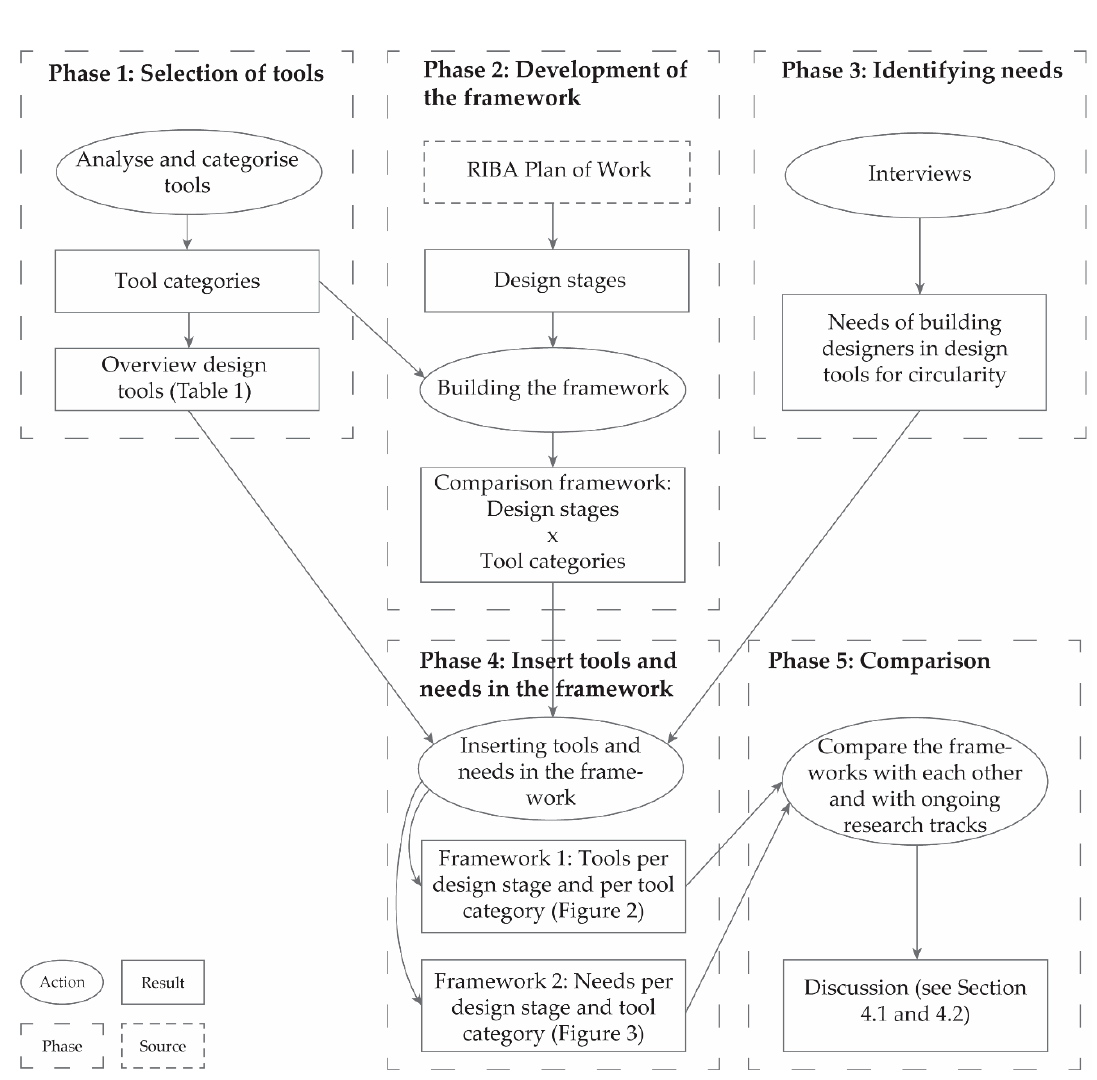
Figure 1. Diagram that shows the actions and results of the five research phases. RIBA is the Royal Institute of British Architects.